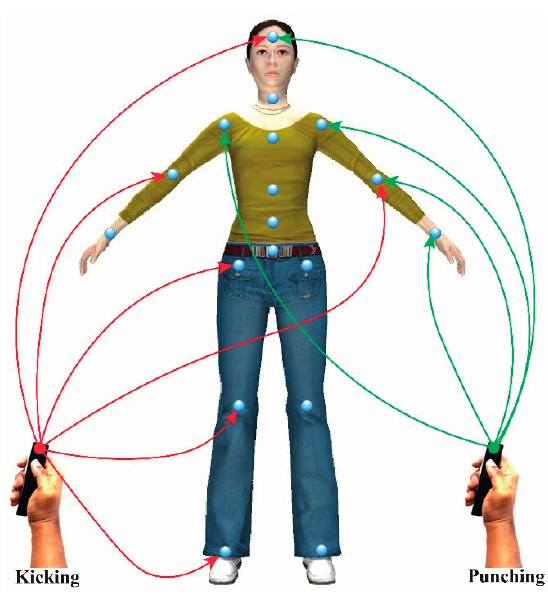
Figure 8. Avatar control using dynamic gesture